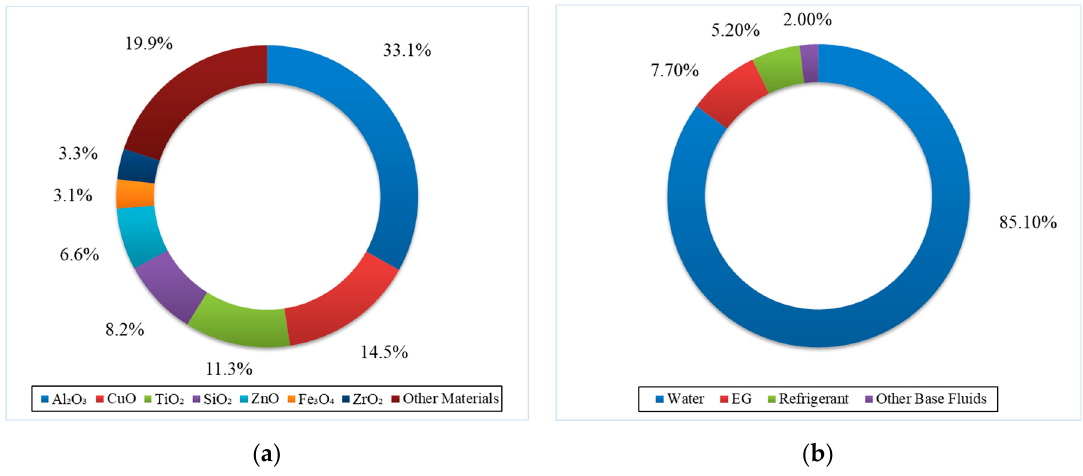
Figure 4. ( a ) Materials and their percentage used as nanoparticles. ( b ) Common materials used as base fluids in the field of nanofluid pool boiling.